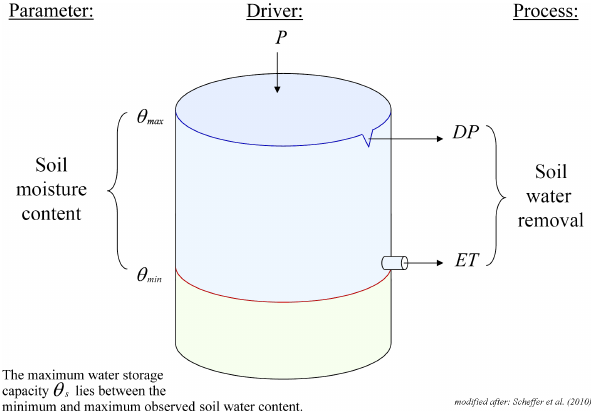
Figure 5. Parsimonious SMSP model of “one-reservoir saturation excess” (modified after Sheffer et al., 2010). Parameters and drivers (top) were field measured for every station and model. The avail- able water content, shown as θ (between SM max and SM min ), is seasonally variable but location specific. Discounting runoff, soil water removal is accounted for in two ways: as SM saturation (red line) increases (above SM min ), evapotranspiration (ET) is triggered first; when θ s reaches SM max , deep percolation (DP) is initiated. Precipitation ( P ) was measured; potential evapotranspiration was calculated from weather station data and transformed into actual ET values (Sect.